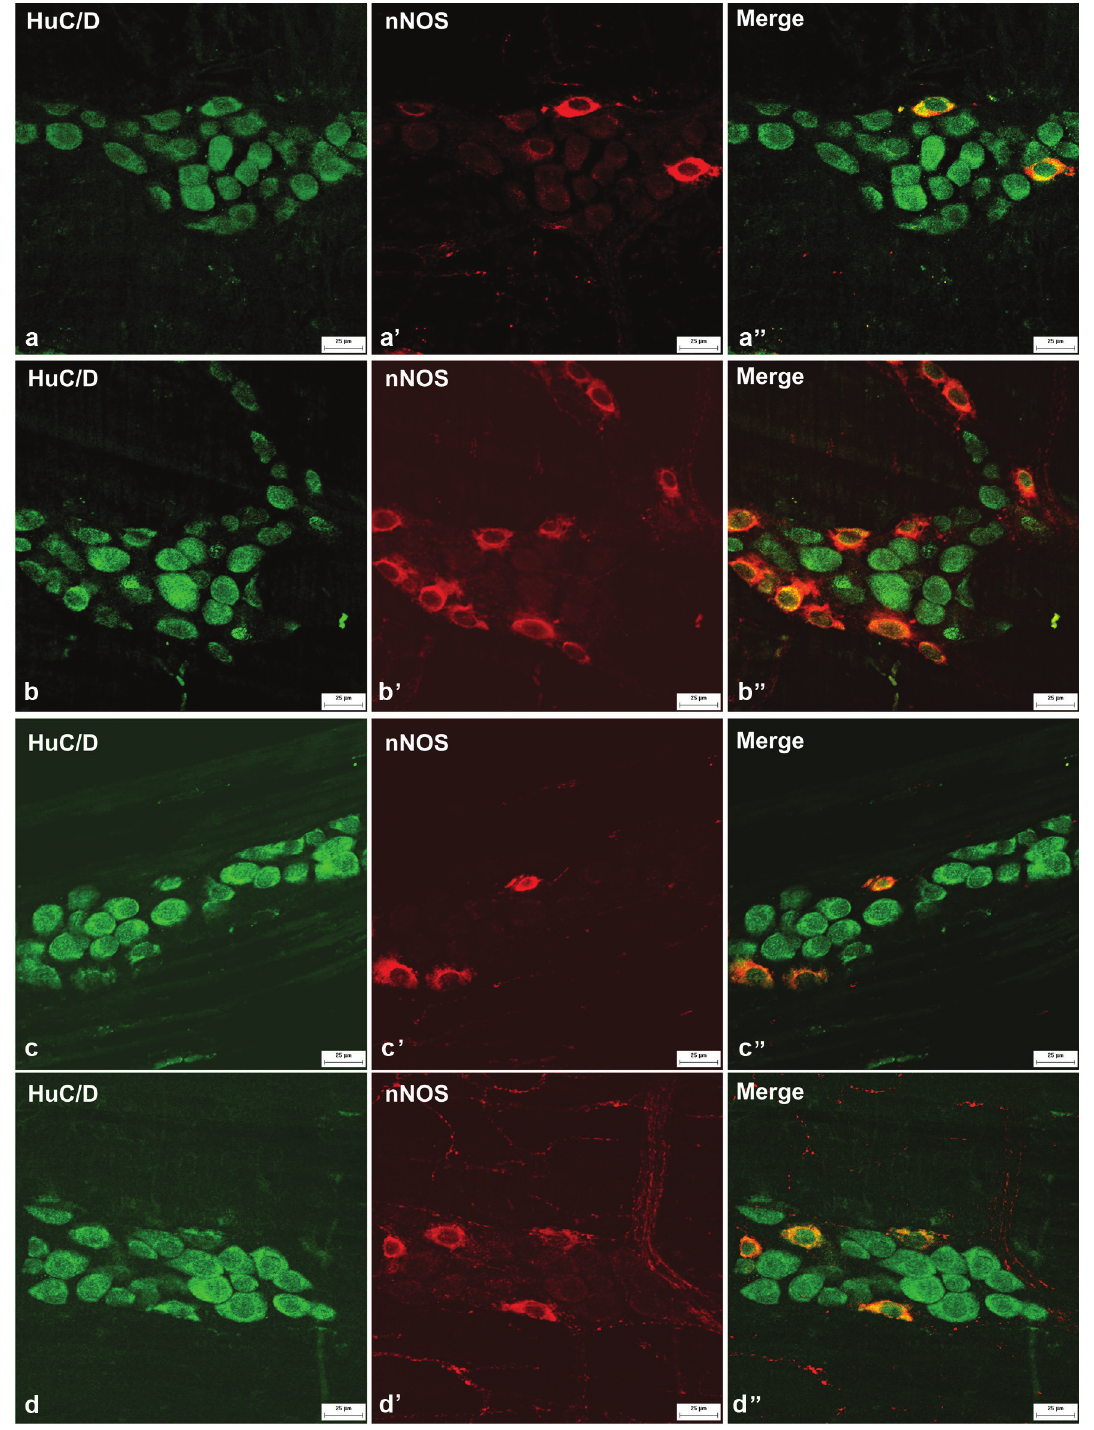
Figure 3 - Confocal photomicrographs of HuC/D-IR ( a, b, c, d ) and nNOS-IR ( a’ , b’ , c’ , d’ ) myenteric neurons in normoglycemics (group N) ( a - a’’ ), normoglycemics supplemented with L-glutamine (group NG) ( b - b’’ ), diabetics (group D) ( c - c’’ ), and diabetics supplemented with L-glutamine (group DG) ( d - d’’ ). Double-labeled HuC/D and nNOS neurons are shown in a’’ , b’’ , c’’ , d’’ . Calibration bar = 25 µm. (See the colors in the online